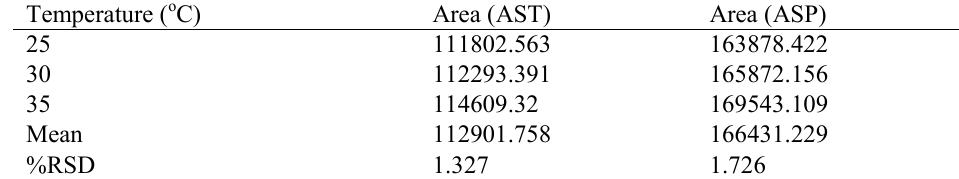
Table 5. Robustness for flow rate studies (temperature).